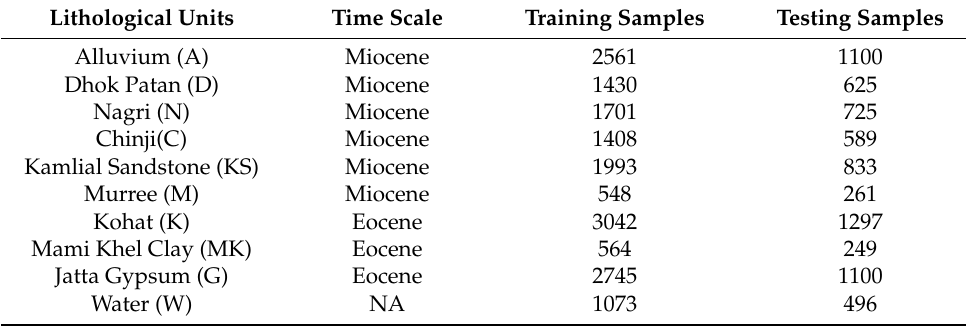
Table 1. The training and testing samples for different classes.